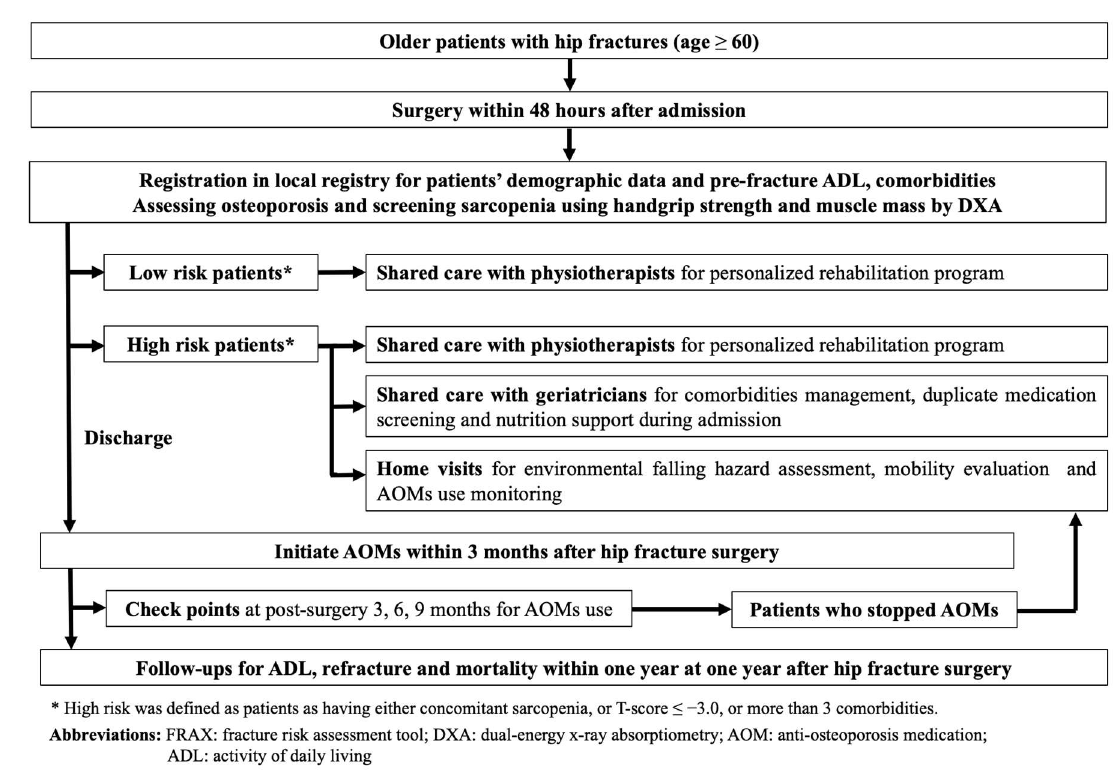
Figure 1. Fracture Liaison Service in Taipei Municipal Wanfang Hospital.